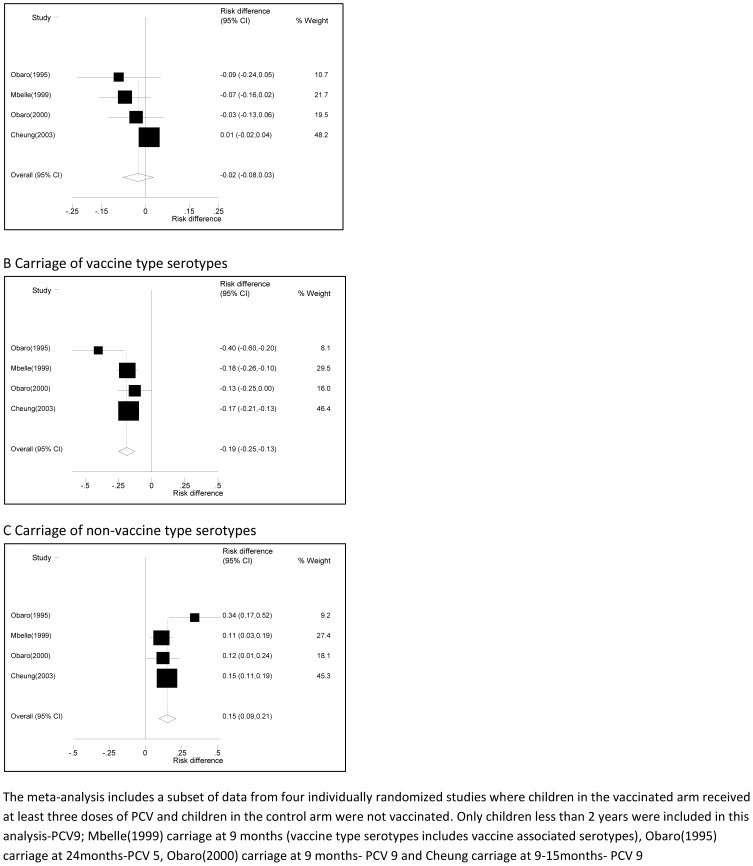
A comparison of pneumococcal carriage in vaccinated and unvaccinated children aged 9–24 months.A positive risk difference indicates higher prevalence in the vaccinated arm.